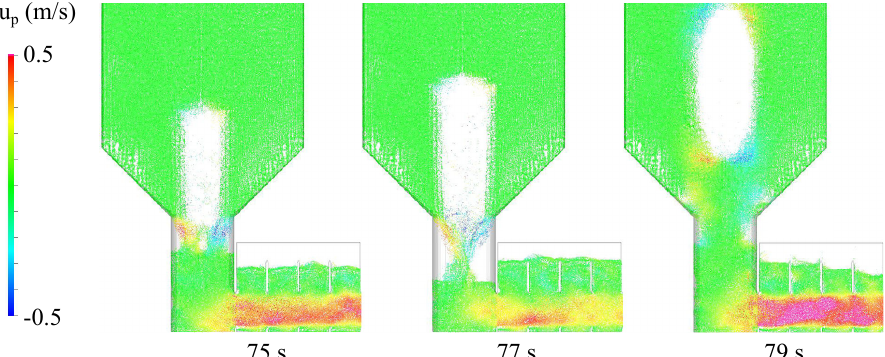
Figure 9. A plot of the horizontal particle flow velocity (in m/s) demonstrates coalescence and disengagement of a large bubble and related particle mass flow fluctuation; ∆ p : |1000 250 200|, FG : |23 10 10 10 10 10 11|